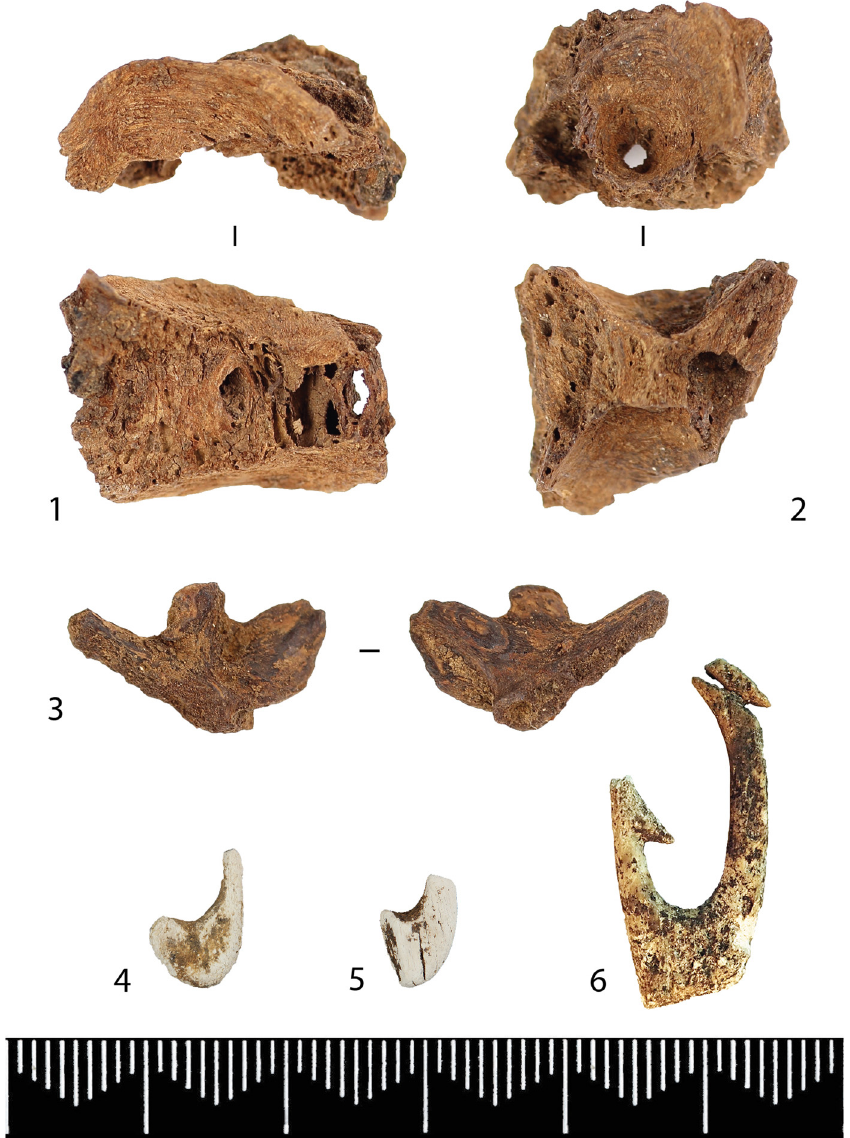
Figure 7: A small collection of unburnt fi sh bones was preserved at Alveberget ( C61487 ) , e.g., vertebrae from fi sh ( 1 – 2 ) and premaxillare from Cod ( Gadus morhua ) ( 3 ) . Fragments of two burnt, small fi shhooks ( 4 – 5 ) made from bone or antler were also found. These are likely of similar type as fi shhooks found at the contemporary site Rörvik, West - Sweden ( 6 ) . Scale: millimeters. Photo: I. M. Berg - Hansen and E. U.Wammer, Illustration: I. M. Berg - Hansen © 2020MuseumofCulturalHistory, University